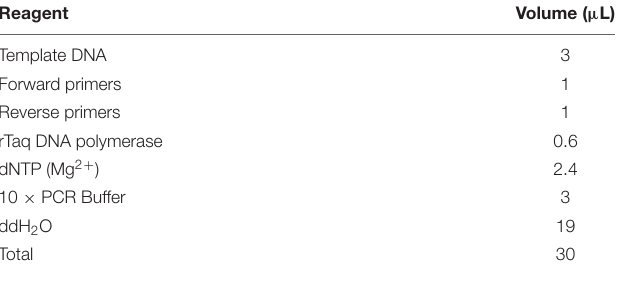
TABLE 4 | PCR system for species-specific primers HGTYI and